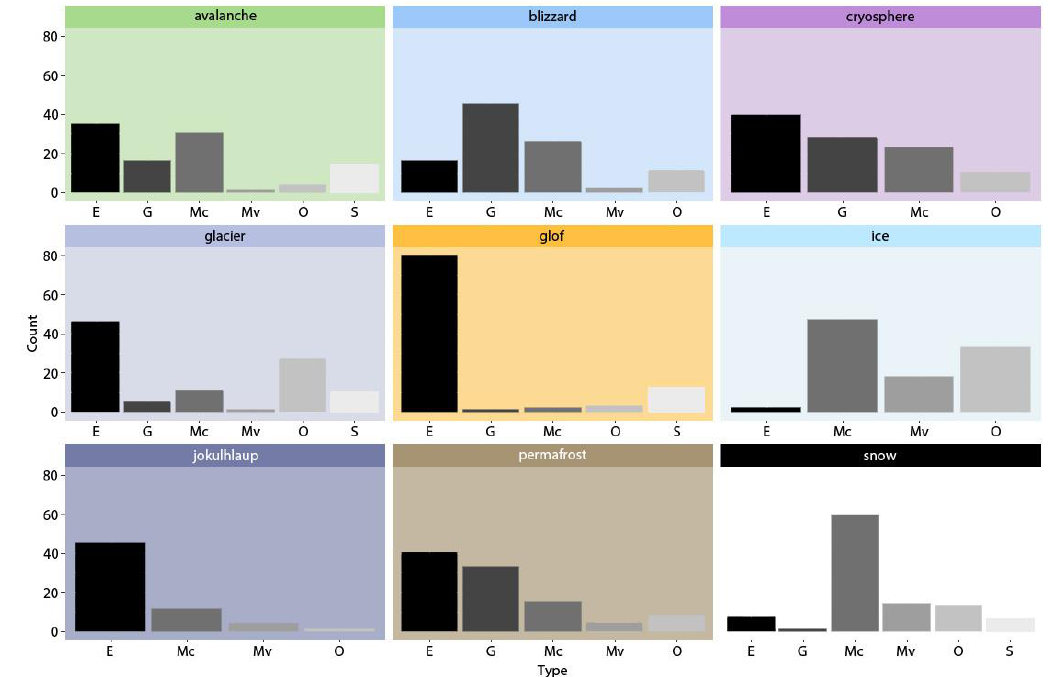
Figure 1. The share of different types of videos found for individual keywords (E - videos with factual cryospheric content; G—gaming videos; Mc—music videos; Mv—movies; S—sports videos; O—others). Note that the amount of videos found for glacial lake outburst flood (GLOFs) (n = 98) and jokulhlaups (n = 61) is lower compared to other keywords (n = 100 for each).